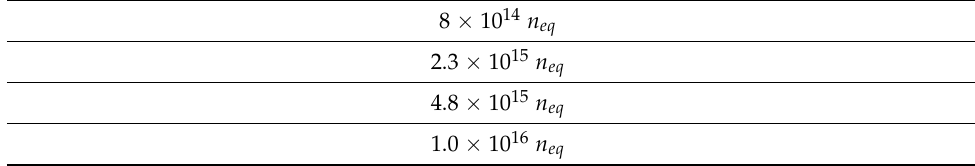
Table 1. Radiation